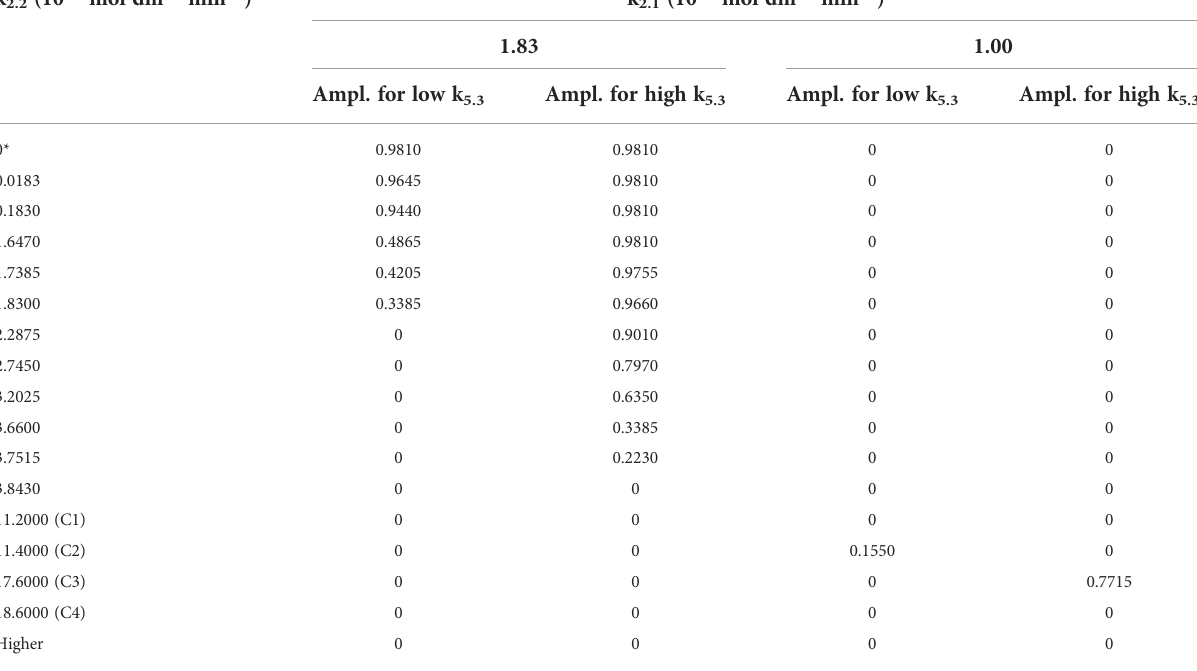
TABLE 3 Oscillation amplitudes of cortisol concentrations (Ampl.) in 10 − 8 mol dm − 3 for two fi xed values of k 2.1 and varied k 2.2